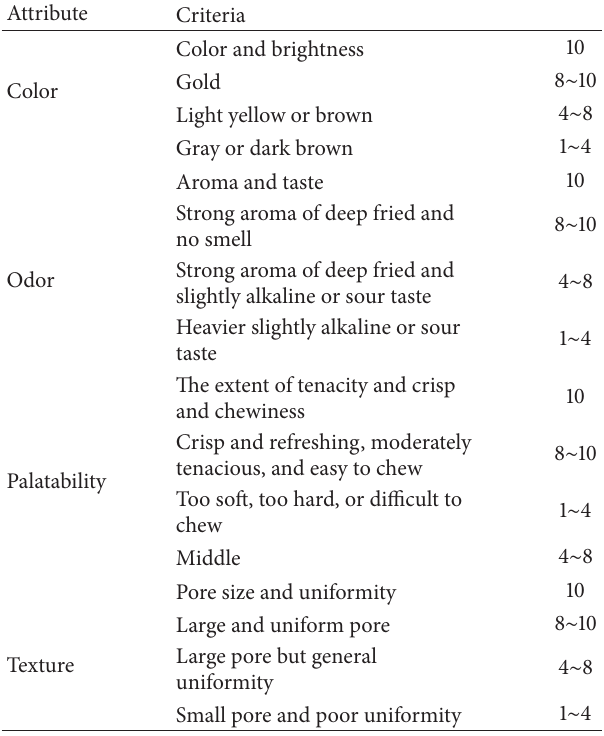
Table 1: The sensory evaluation criteria of fried